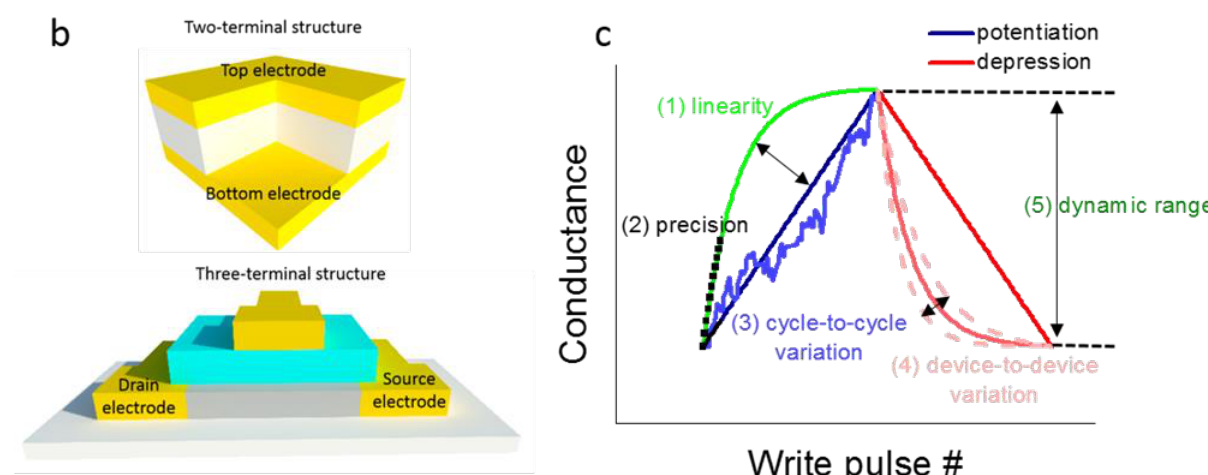
Figure 2. ( a ) Schematic structure of fully connected ANN. ( b ) Schematic structure of two-terminal- and three-terminal-based synaptic devices. ( c ) An overview of functional metrics of analog resistive switching for improved learning capability